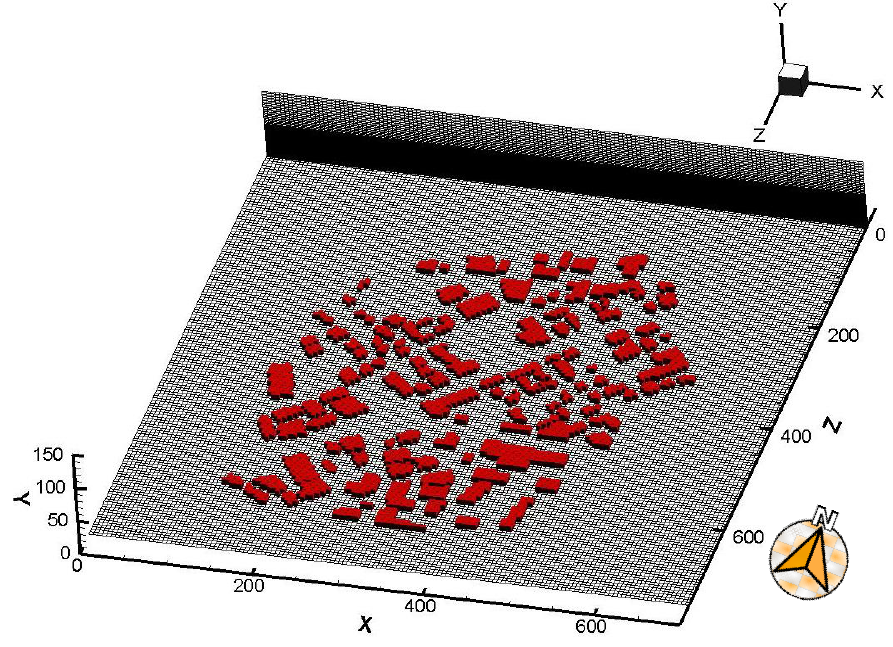
Figure 2. Cartesian grid for the computational domain 700 × 100 × 750 with a total of ~1.6Μ cells.